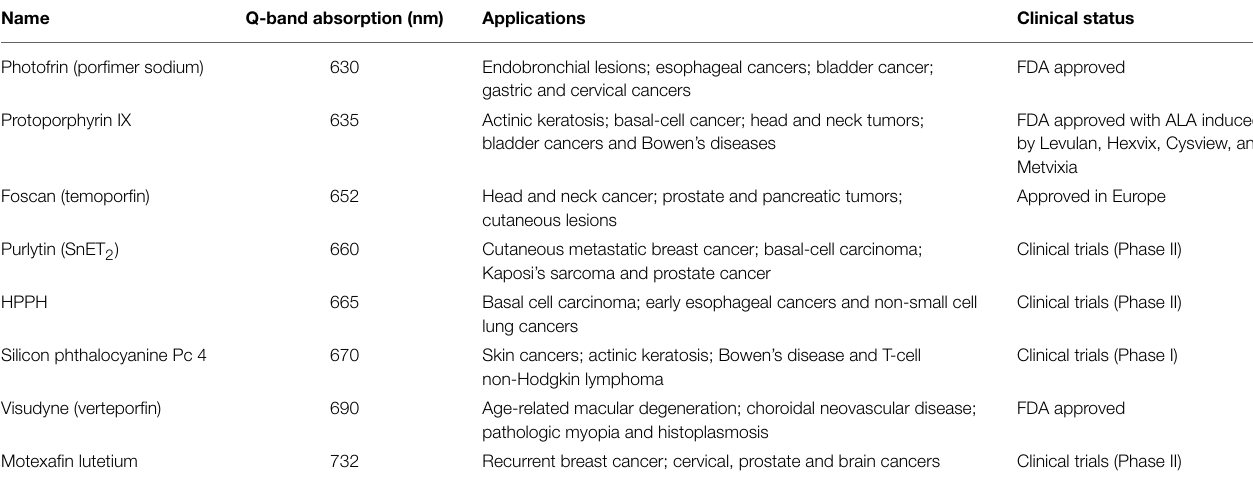
TABLE 1 | Selected clinical photosensitizers.